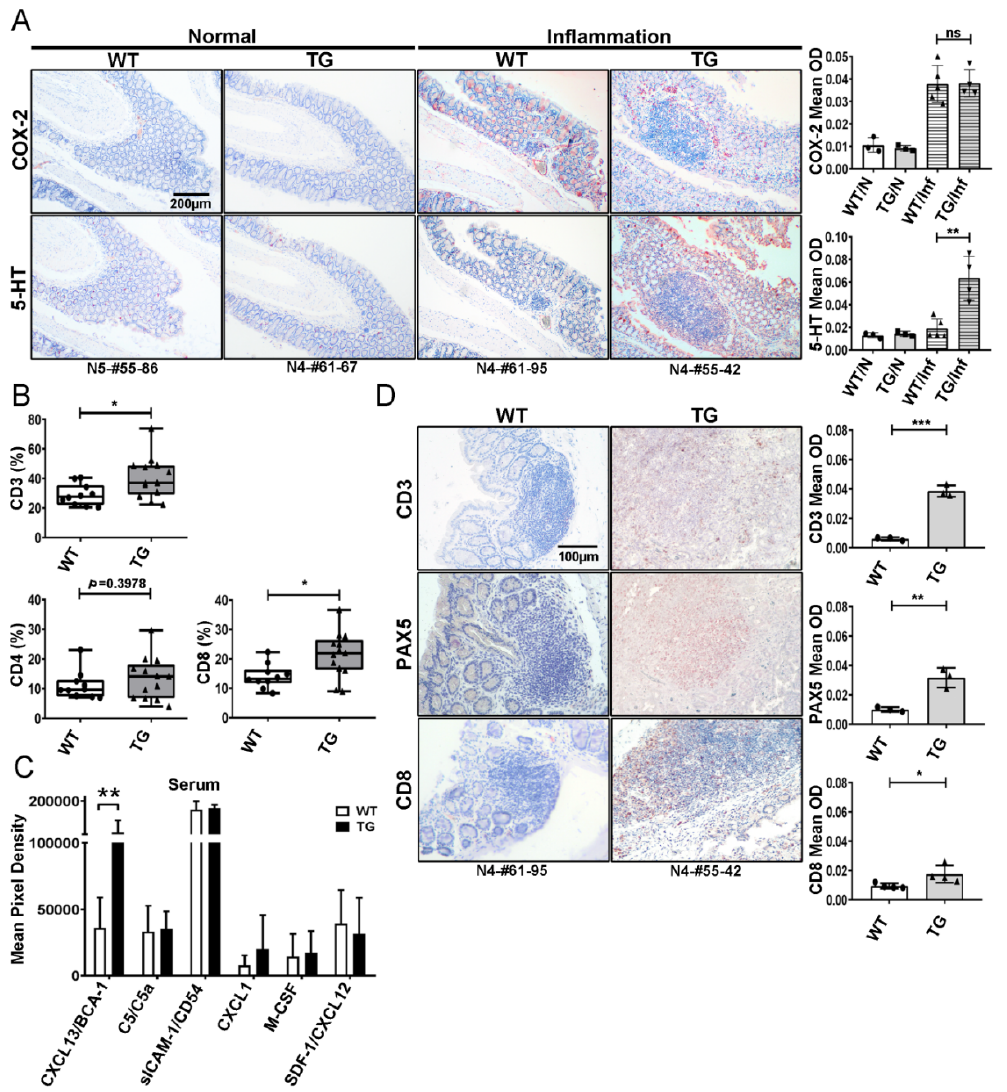
Figure 3. TIAM2S expression triggers serotonin-induced cellular immunity. ( A ) Representative histologic images of IHC staining of anti-COX-2 (upper panel) and anti-serotonin (lower panel) antibodies in colon sections of WT and TIAM2S-TG mice (number indicates mice ID). The levels of COX-2 and serotonin in different groups were approximated by the mean optical density (OD) quantified using Image J. ( B ) Summary data from fluorescence-activated cell sorting analysis show T lymphocyte distributions in the serum from WT and TG animals. Total and sub-population of T cells were recognized with anti-CD3 (upper panel), anti-CD4 (lower left), and anti-CD8 (lower right) antibodies. ( C ) Pro-inflammatory and inflammatory factors were profiled with serums from WT and TIAM2S-TG animals using cytokine and chemokine array and quantified signals of mean pixel density were compared. The level of CXCL13/BCA-1 was elevated in TG groups ( p = 0.0097 by Student’s t -test). ( D ) Representative histologic images of inflamed colon sections from WT and TG mice were IHC stained with Anti-CD3 and -CD8 antibodies (T lymphocyte marker) and Anti-PAX5 antibody (B cell marker) to confirm the immune cell activation. For all statistics, NS: not significant, * p < 0.05, ** p < 0.01, *** p < 0.001.